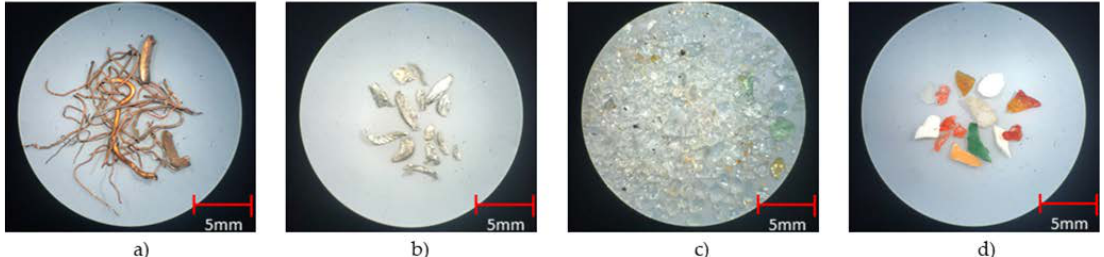
Figure 1. Microscopic photographs of various materials from automobile shredder residue (ASR). ( a ) copper, ( b ) aluminum, ( c ) glass, and ( d ) other materials.